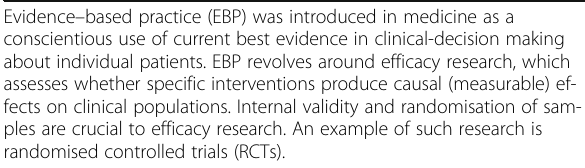
Table 3 Key concept: evidence-based practice (EBP) Evidence – based practice (EBP) was introduced in medicine as a conscientious use of current best evidence in clinical-decision making about individual patients. EBP revolves around efficacy research, which assesses whether specific interventions produce causal (measurable) ef- fects on clinical populations. Internal validity and randomisation of sam- ples are crucial to efficacy research. An example of such research is randomised controlled trials